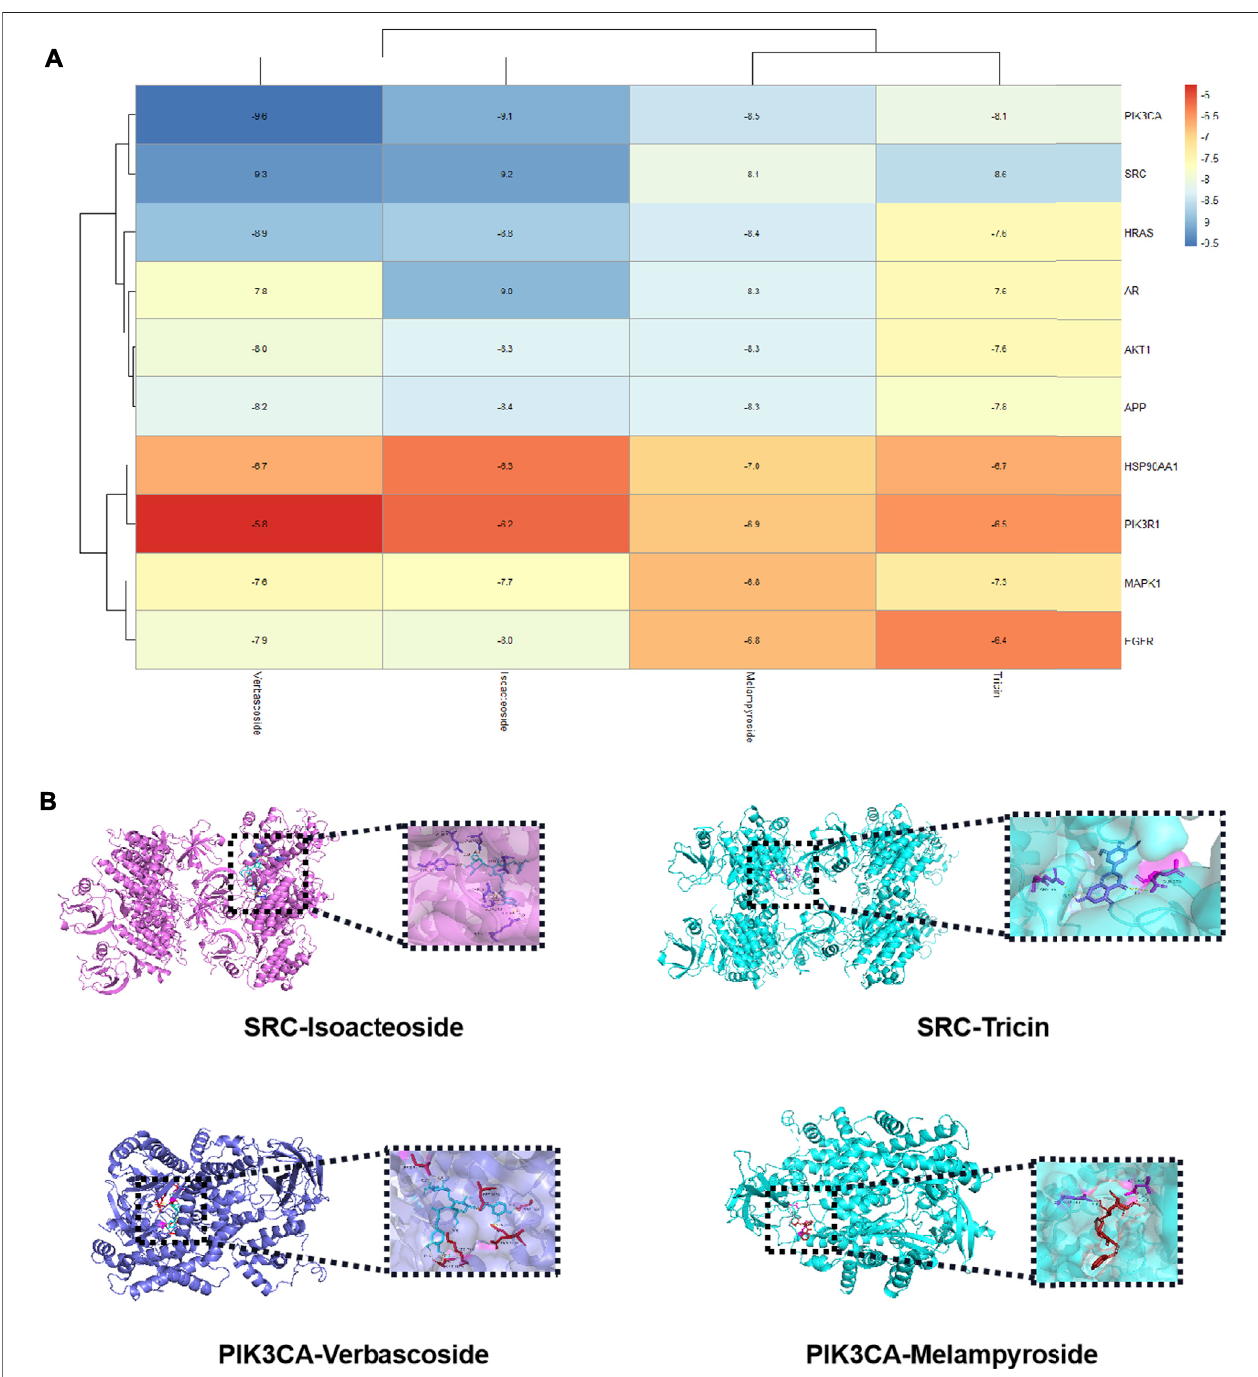
FIGURE 9 | (A) Heat map of binding energy between the compounds of O. vulgaris and core targets molecule docking. (B) Docking modl diagram of compound and key target molecule.